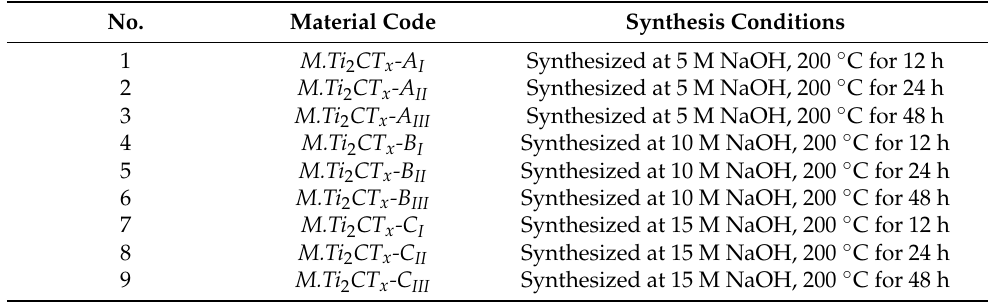
Table 1. M.Ti 2 CT x hybrid nanostructures synthesized using Ti 2 AlC and FeSO 4 .7H 2 O at different NaOH concentrations, temperatures, and